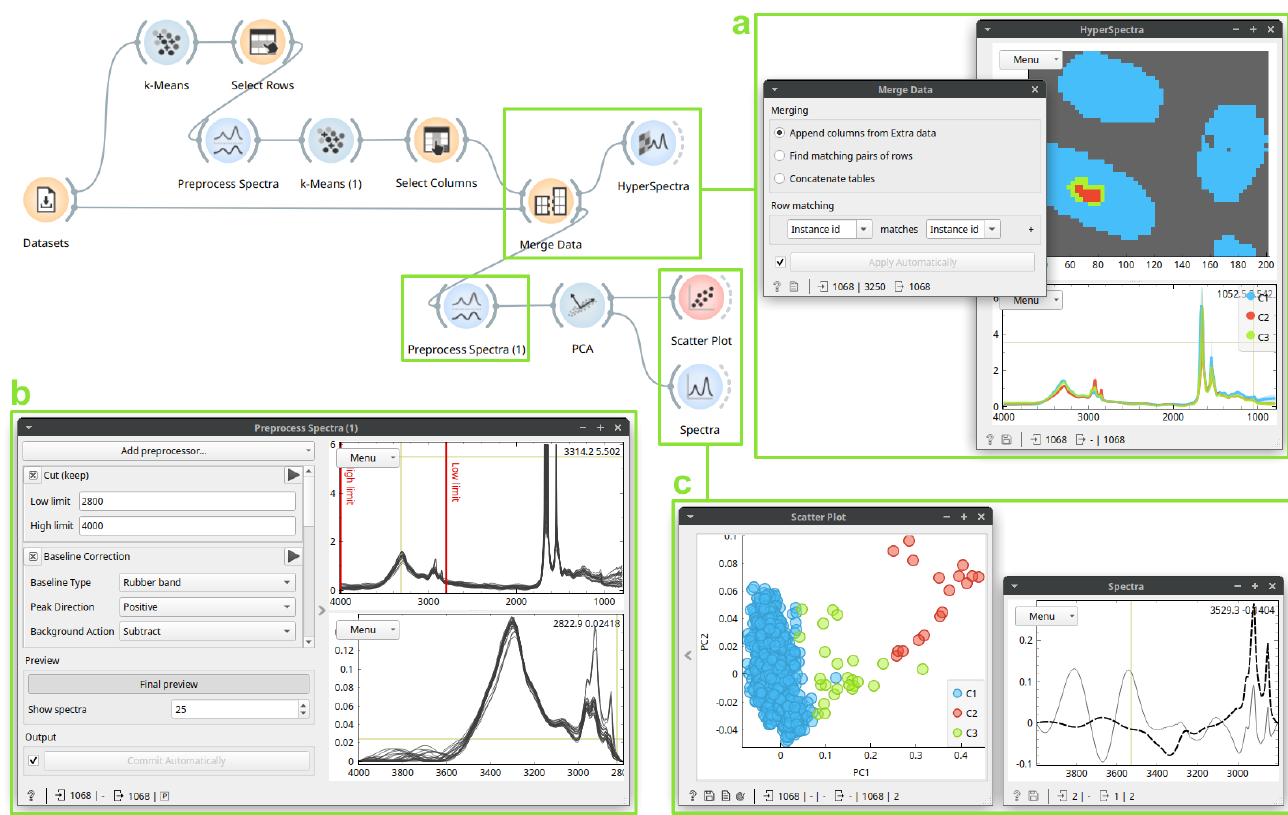
Figure 3. An unsupervised analysis on a section of multiple hair samples, continued from Figure 2. Here, a Merge Data (box a , left ) widget merges the clusters obtained with the previous data for further analysis. The clusters merged with original spectra may be seen in the Hyperspectra widget (box a , right ). Here, Preprocess Spectra baseline-corrects and normalizes the data (box b ). We then investigate results of the PCA : in the Scatter Plot (box c , left ), the red cluster has high PC1 scores, whose loadings, shown in the Spectra (box c , right ), contain a characteristic lipid signature between 3000–2800 cm − 1